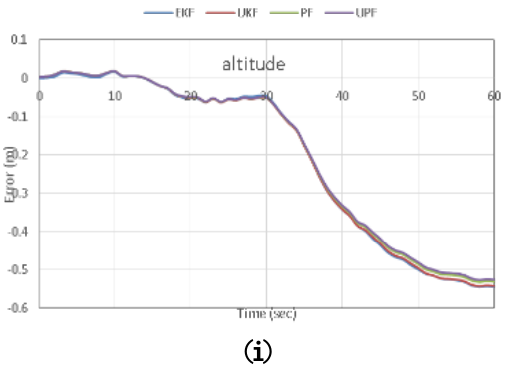
Figure 10. Positioning accuracy during GPS outages for latitude, longitude, and altitude.